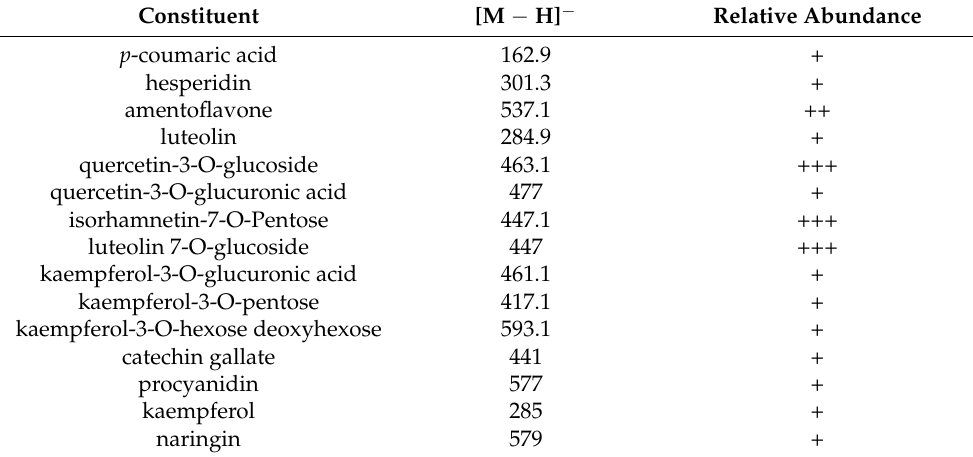
Figure 2. Cytotoxicity of the polyphenol-enriched fraction extracted from Myrtus communis for the normal Vero cell line. Relative viability of Vero cells after 24–72 h of treatment with different con- centrations of the PEMC (12–100 µg/mL). The absorbance values were measured at the wavelength of 570 nm, and the mean values ± SD of three experiments, the cell viability was estimated by the MTT assay.